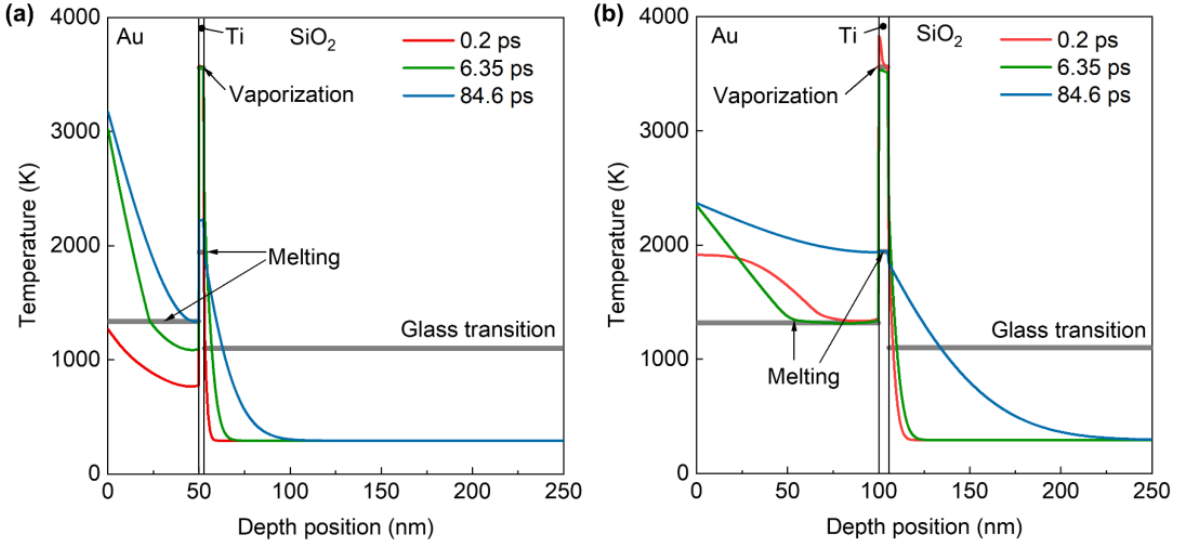
Figure 5. Lattice temperature distribution along the depth position at the moment of ablation. ( a ) 50 nm- and ( b ) 100 nm-thick Au films. For 100 nm-thick Au film, significant amount of heat is conducted to the glass substrate for long pulse duration to induce glass transition.